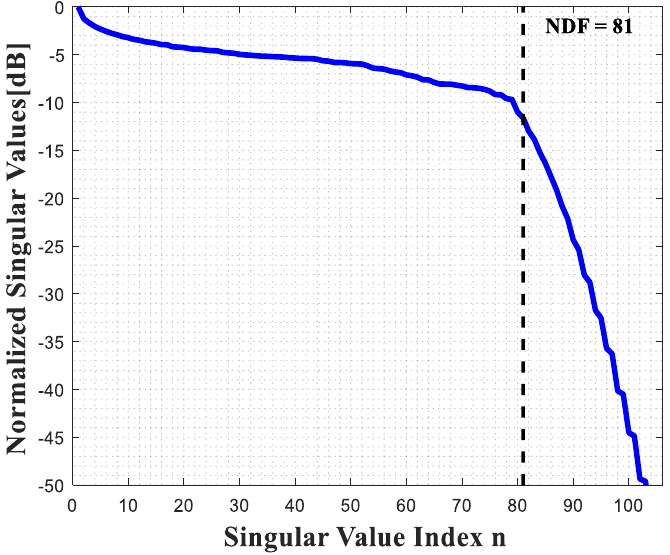
Figure 19. The normalized distribution of singular values of the relevant operator.